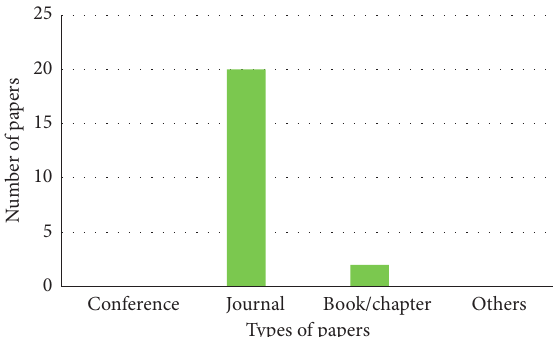
Figure 6: Types of papers with the total number of